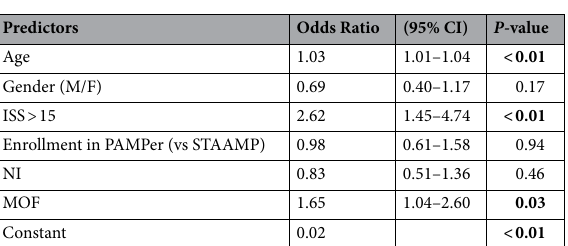
Table 3. Predictive factors for 30-day mortality. OR: Odds Ratio, CI: Confidence Interval, ISS: injury severity score; NI: nosocomial infection; MOF: multiorgan failure. Significant values are in